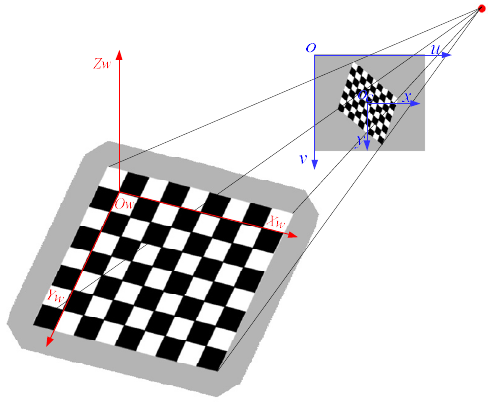
Figure 3. Coordinate systems.